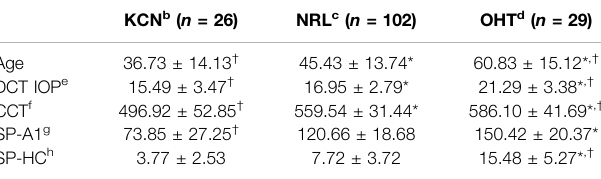
TABLE 2 | Subject characteristics for age and IOP, along with stiffness metrics represented by mean ± standard deviation a .